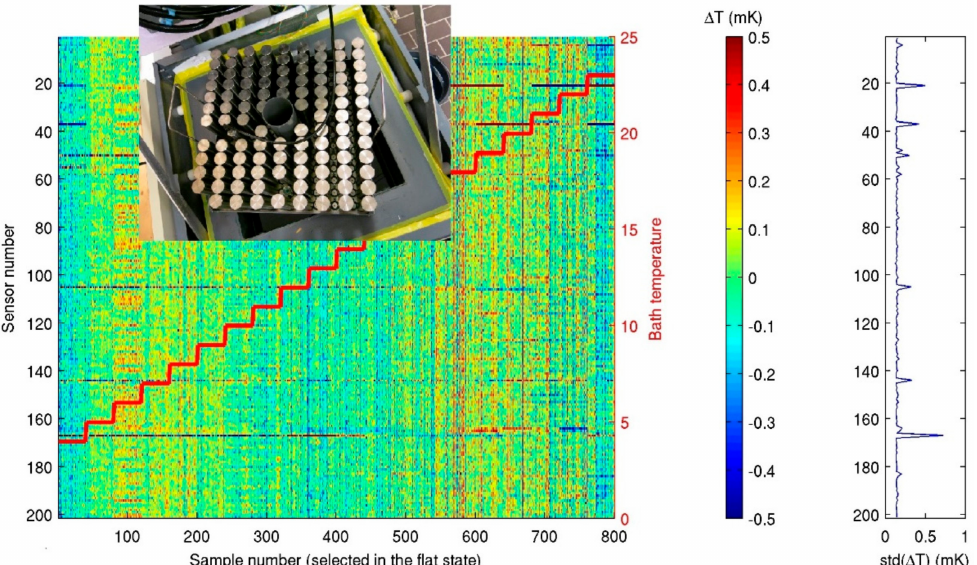
Figure 2. Laboratory calibration bath. Insert photo shows about 200 T-sensors upside-down in a titanium plate lifted out of the 32 L content bath. A large diagram shows the step-wise temperature in red overlaying the T-sensors discrepancy at the stable T-steps with s.d. of mean values given in the right figure. (Note about six sensors showing some anomalous behavior extending above the 0.1 mK mean